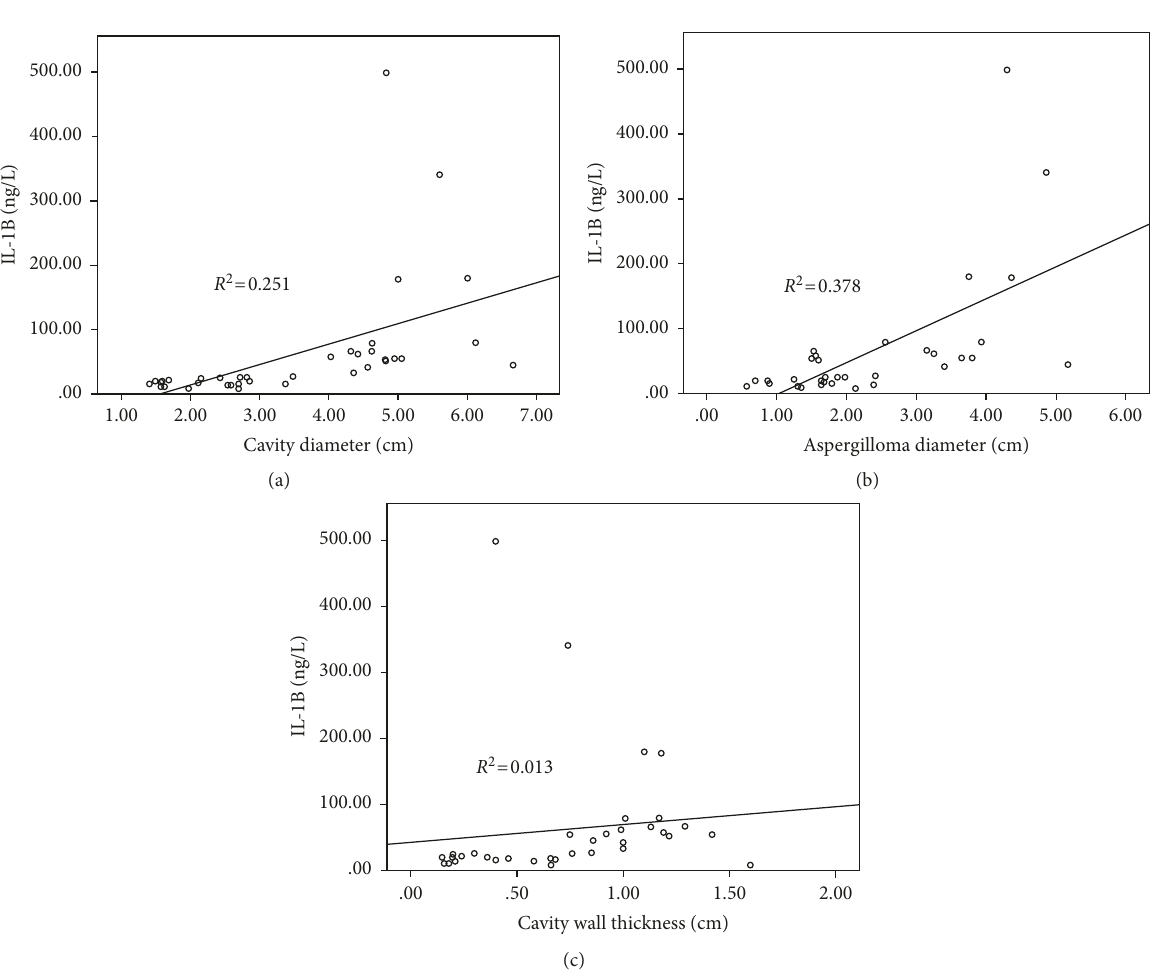
0 . 501, P 0 . 002) (a) and (cid:31) (cid:31) 0 . 114, P 0 . 496) (cid:31) (cid:31)